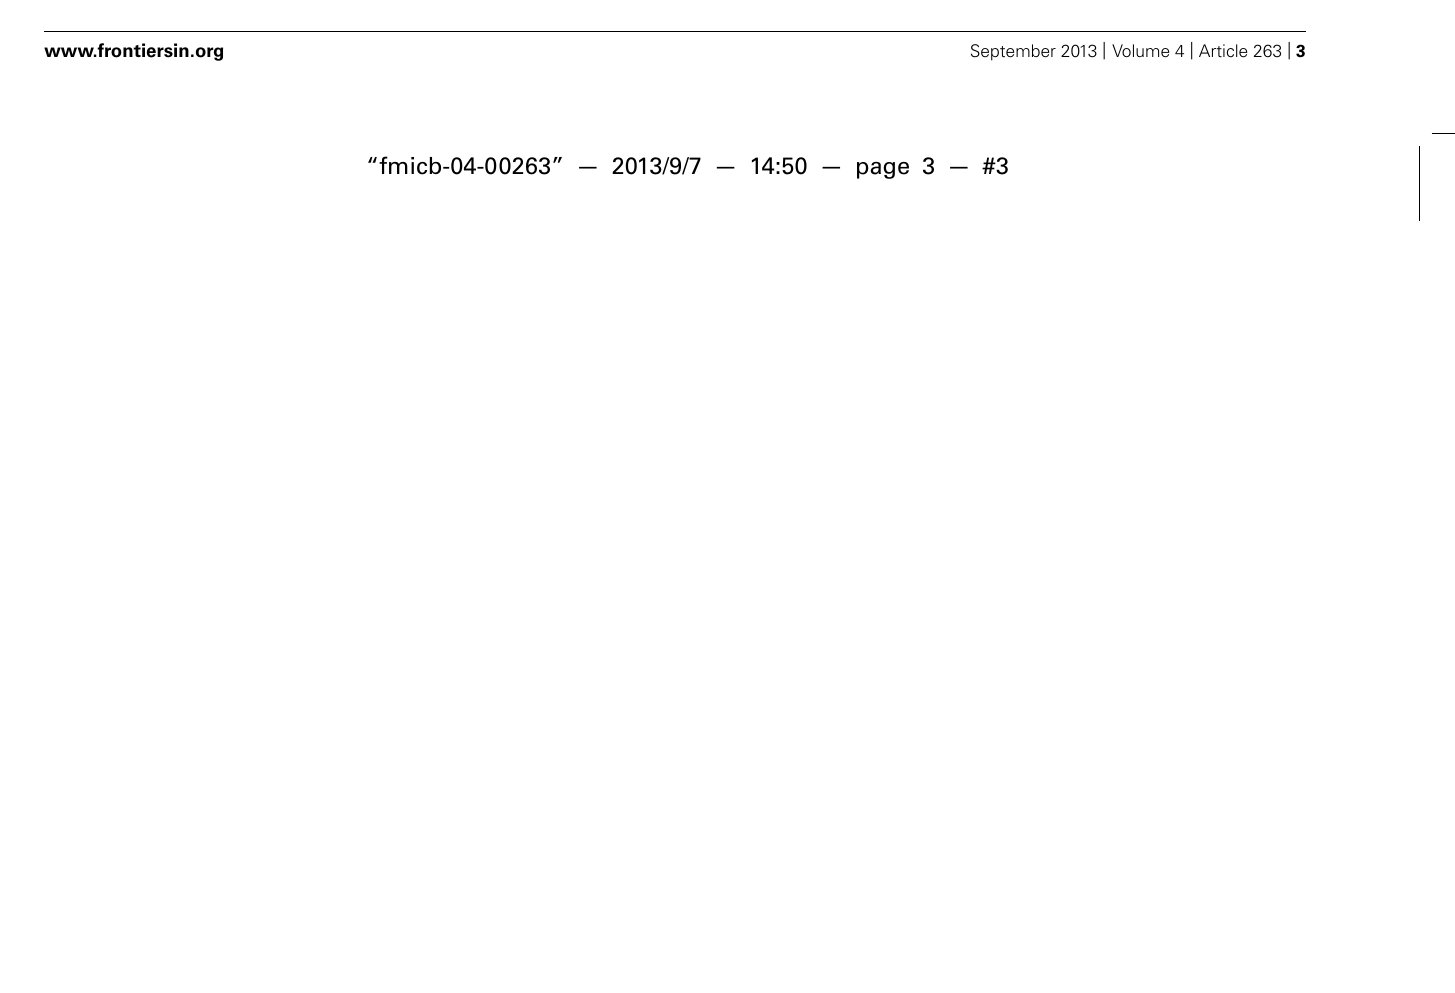
FIGURE 1 | Regulation ofASM contractility . ASM contraction is induced by calcium, regulated two different pathways. First, ASM is evoked by intracellular calcium influx from SR depending on GPCR stimulation or from the extracellular environment through voltage- dependent calcium channel. Second, smooth muscle can be induced calcium sensitivity by RhoA/Rho kinase pathway. RhoA activates